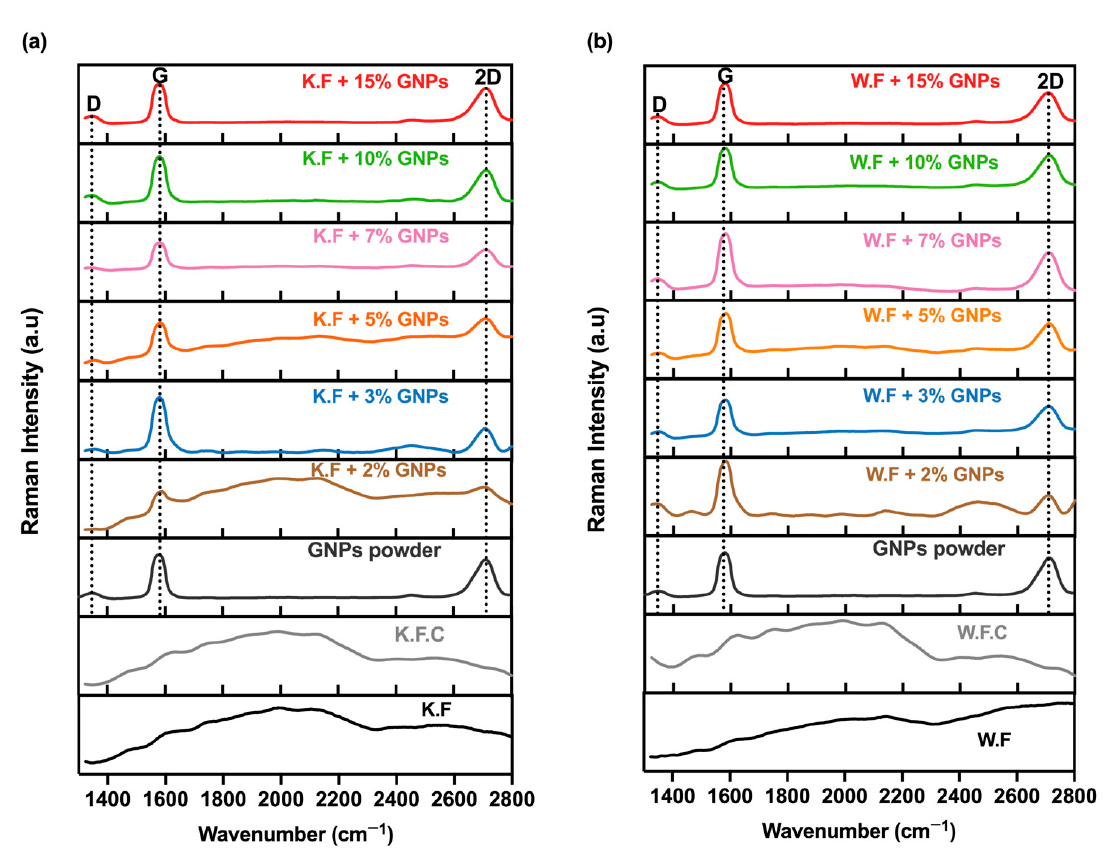
Figure 9. ( a ) Raman spectra of non-functionalised and functionalised knitted fabrics with different GNPs %; ( b ) Raman spectra of non-functionalised and functionalised woven fabrics with different GNPs %. The dotted line indicates the D, G and 2D peaks for the Graphene powder and all functionalised samples.